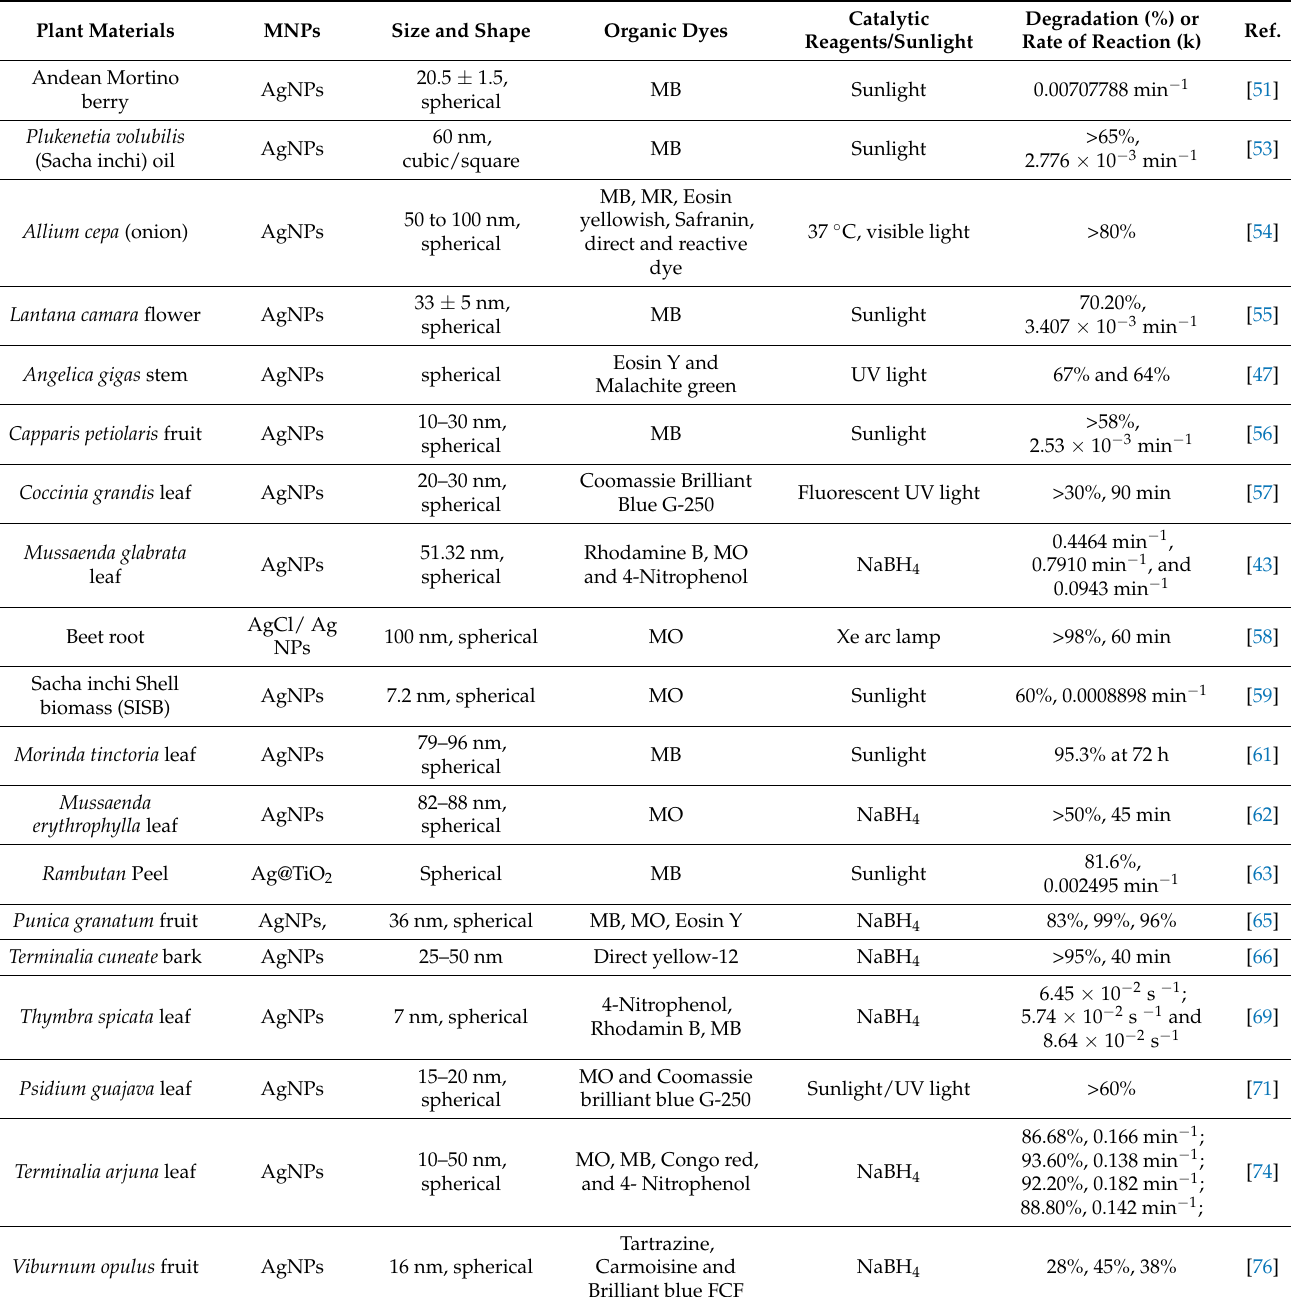
Table 2. Synthesis of silver nanoparticles using different plant extracts and their degradation